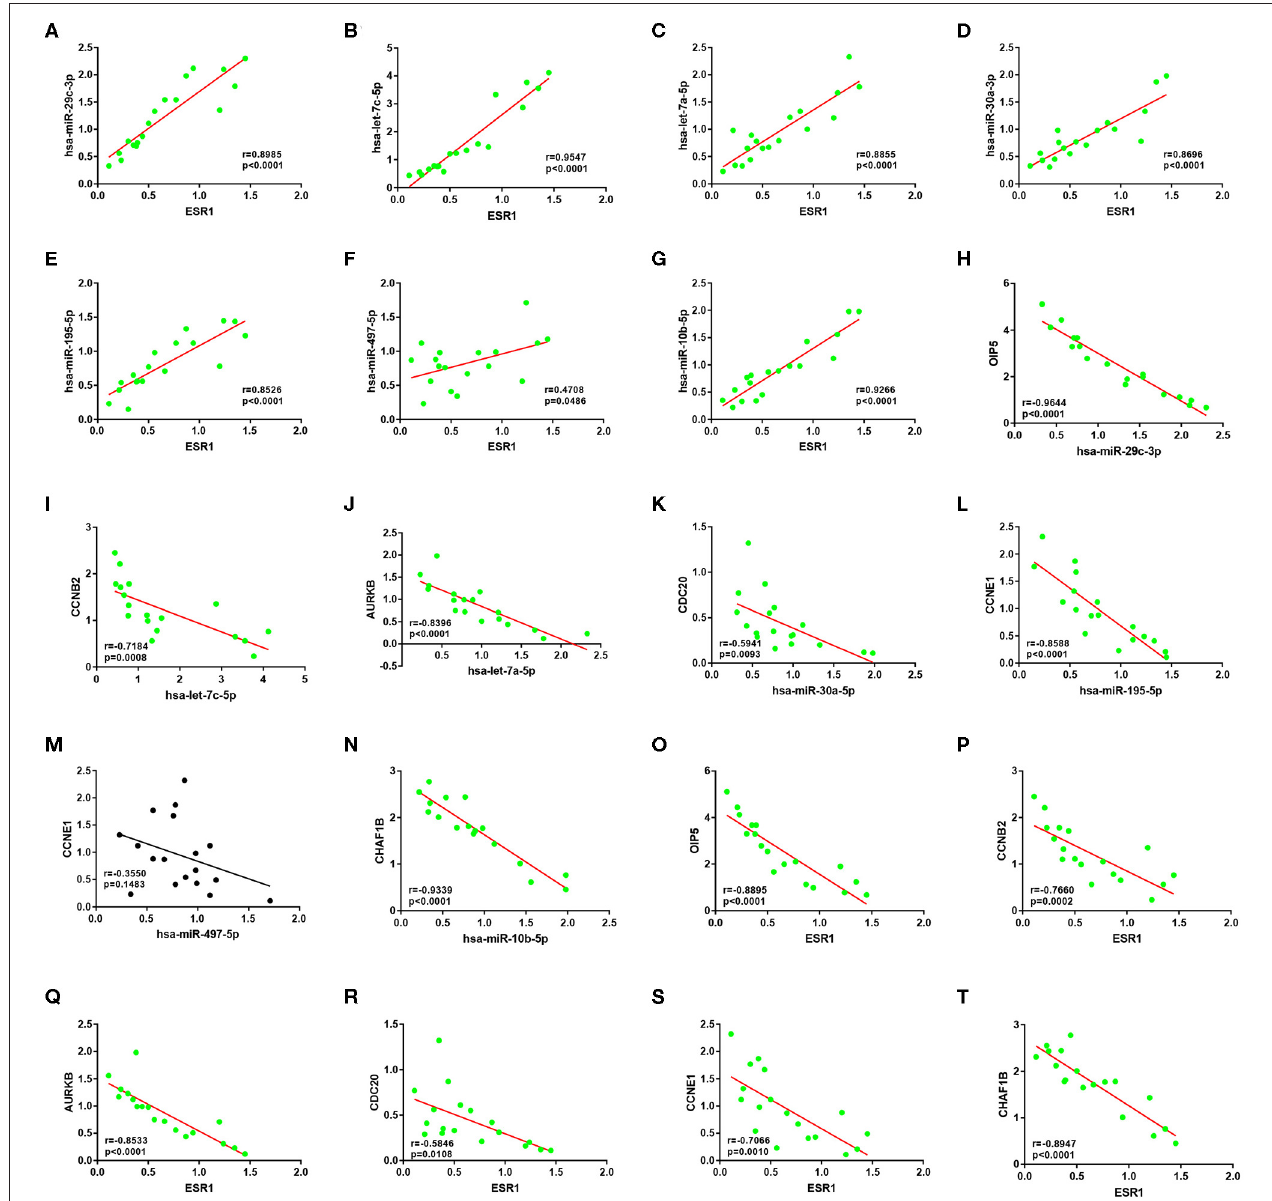
FIGURE 9 | The expression correlation between ESR1-miRNA, miRNA-mRNA or ESR1-mRNA pairs of ESR1-miRNA-mRNA network in clinical ER-positive breast cancer. (A) ESR1/hsa-miR-29c-3p pair. (B) ESR1/hsa-let-7c-5p pair. (C) ESR1/hsa-let-7a-5p pair. (D) ESR1/hsa-miR-30a-3p pair. (E) ESR1/hsa-miR-195-5p pair. (F) ESR1/hsa-miR-497-5p pair. (G) ESR1/hsa-miR-10b-5p pair. (H) hsa-miR-29c-3p/OIP5 pair. (I) hsa-let-7c-5p/CCNB2 pair. (J) hsa-let-7a-5p/AURKB pair. (K) hsa-miR-30a-3p/CDC20 pair. (L) hsa-miR-195-5p/CCNE1 pair. (M) hsa-miR-497-5p/CCNE1 pair. (N) hsa-miR-10b-5p/CHAF1B pair. (O) ESR1/OIP5 pair. (P) ESR1/CCNB2 pair. (Q) ESR1/AURKB pair. (R) ESR1/CDC20 pair. (S) ESR1/CCNE1 pair. (T) ESR1/CHAF1B pair.